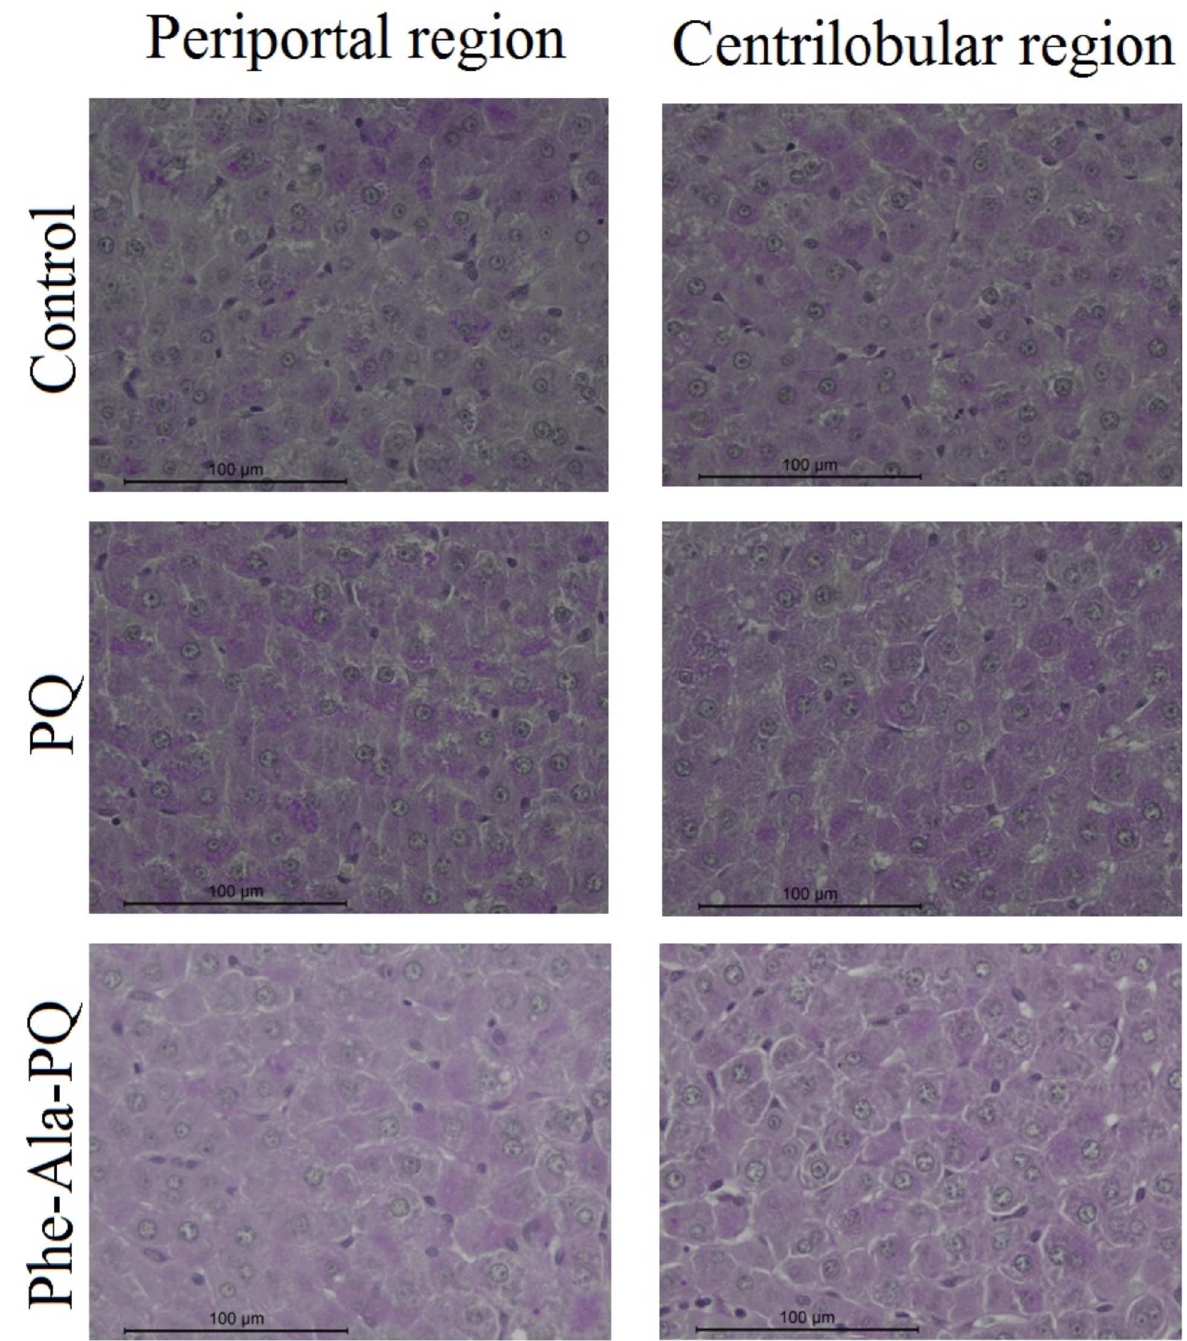
Figure 1. Photomicrographs of rat liver focusing on the periportal and centrilobular regions (hematoxylin/eosin staining, 40 6 original magnification, Bars =100 m m).